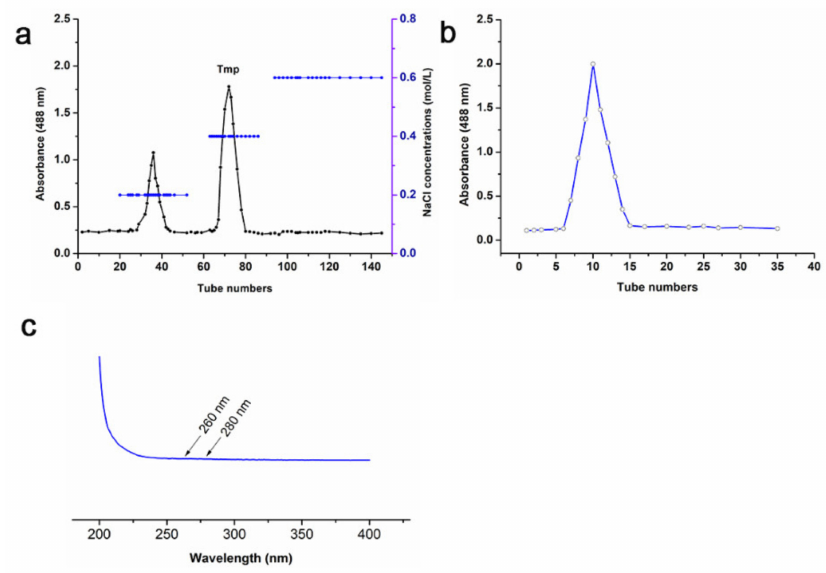
Figure 1. Chromatography of Tmp purified by DEAE-52 chromatography ( a ) and Sephadex G-200 ( b ); UV spectrum of Tmp ( c